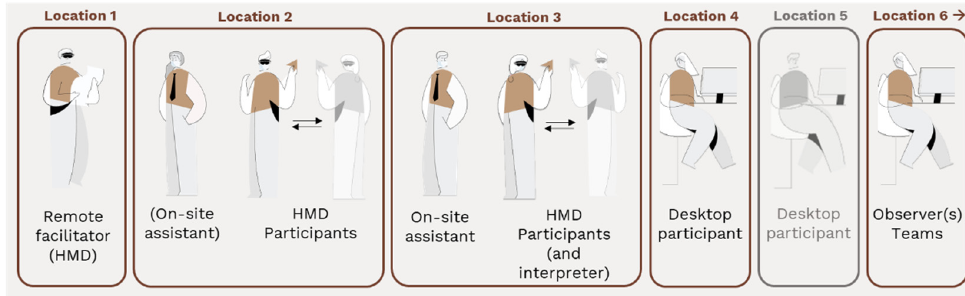
Figure 11. The user test setup in Case 4.